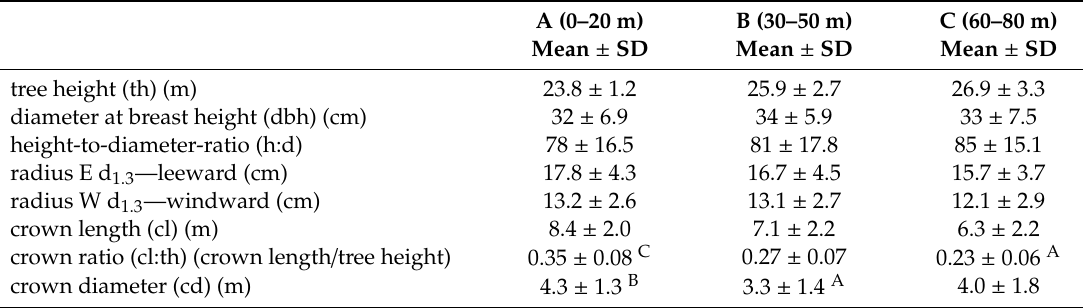
Table 3. Model trees characteristics.